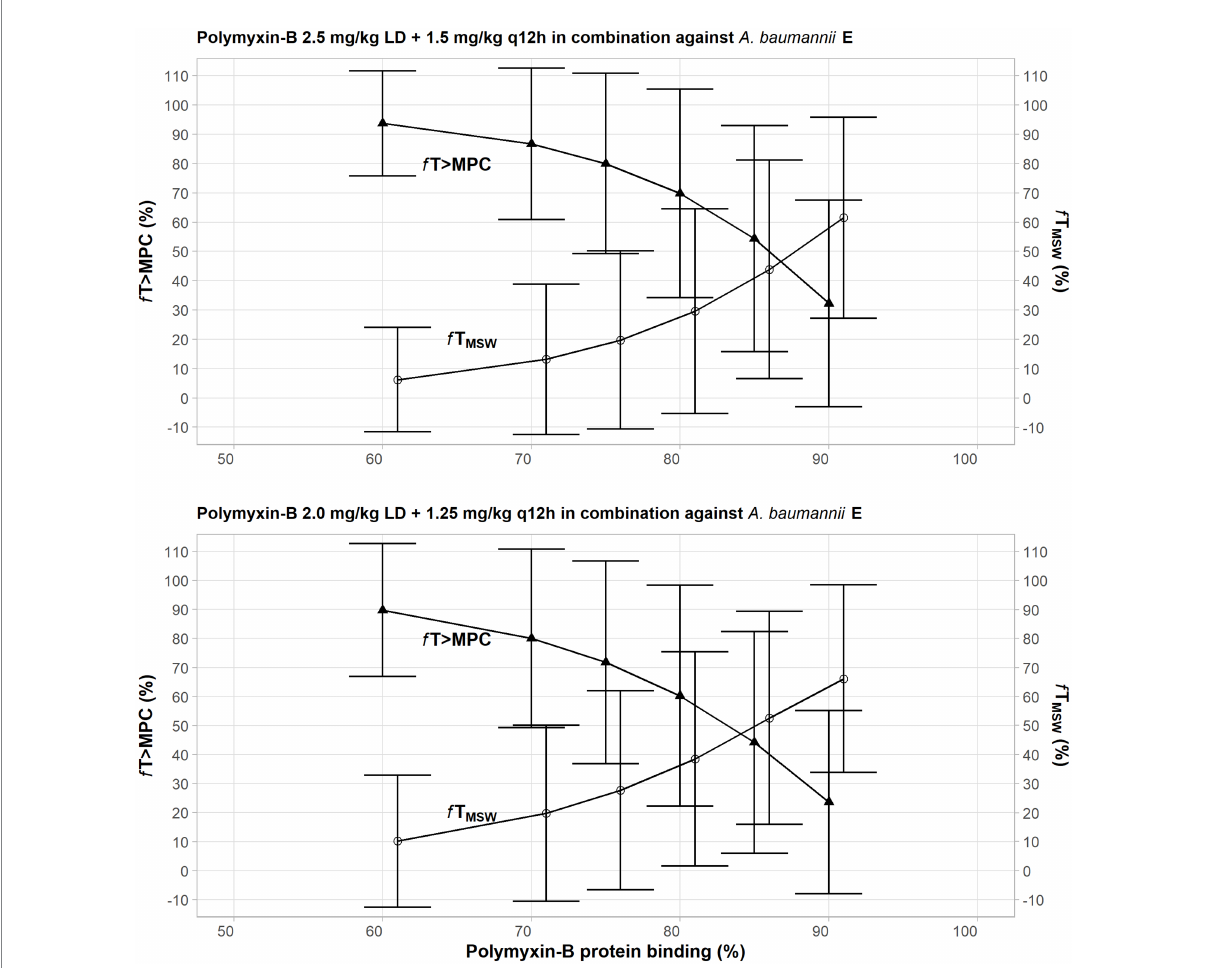
FIGURE 3 Sensitivity analysis to evaluate effect of variability in polymyxin plasma protein binding on the pharmacodynamic parameters f T MSW and f T >MPC after polymyxin dosing regimens in combination therapy consisting of loading dose 2.5 mg/kg followed by 1.5 mg/kg q12h at 12 h (top) and loading dose 2 mg/kg followed by 1.25 mg/kg q12h at 12 h (bottom) against Acinetobacter baumannii 20. The models assumed polymyxin-B MIC of 1 mg/l and MPC of 4 mg/l, whereas amikacin MIC and MPC were both 4 mg/l with or without 4 mg/l sulbactam. In this scenario, the proposed dosing regimens of both amikacin and sulbactam can achieve PTA ≥ 90%.